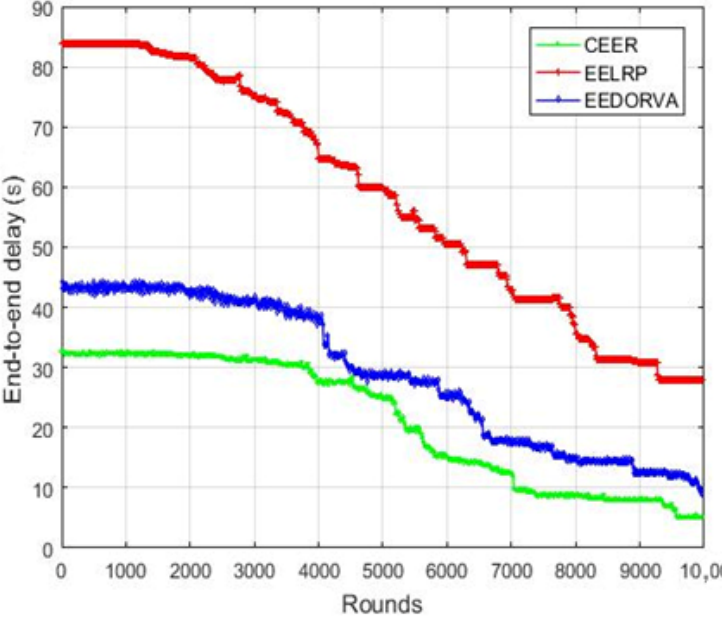
Figure 7. End-to-end delay of the proposed and existing protocols.